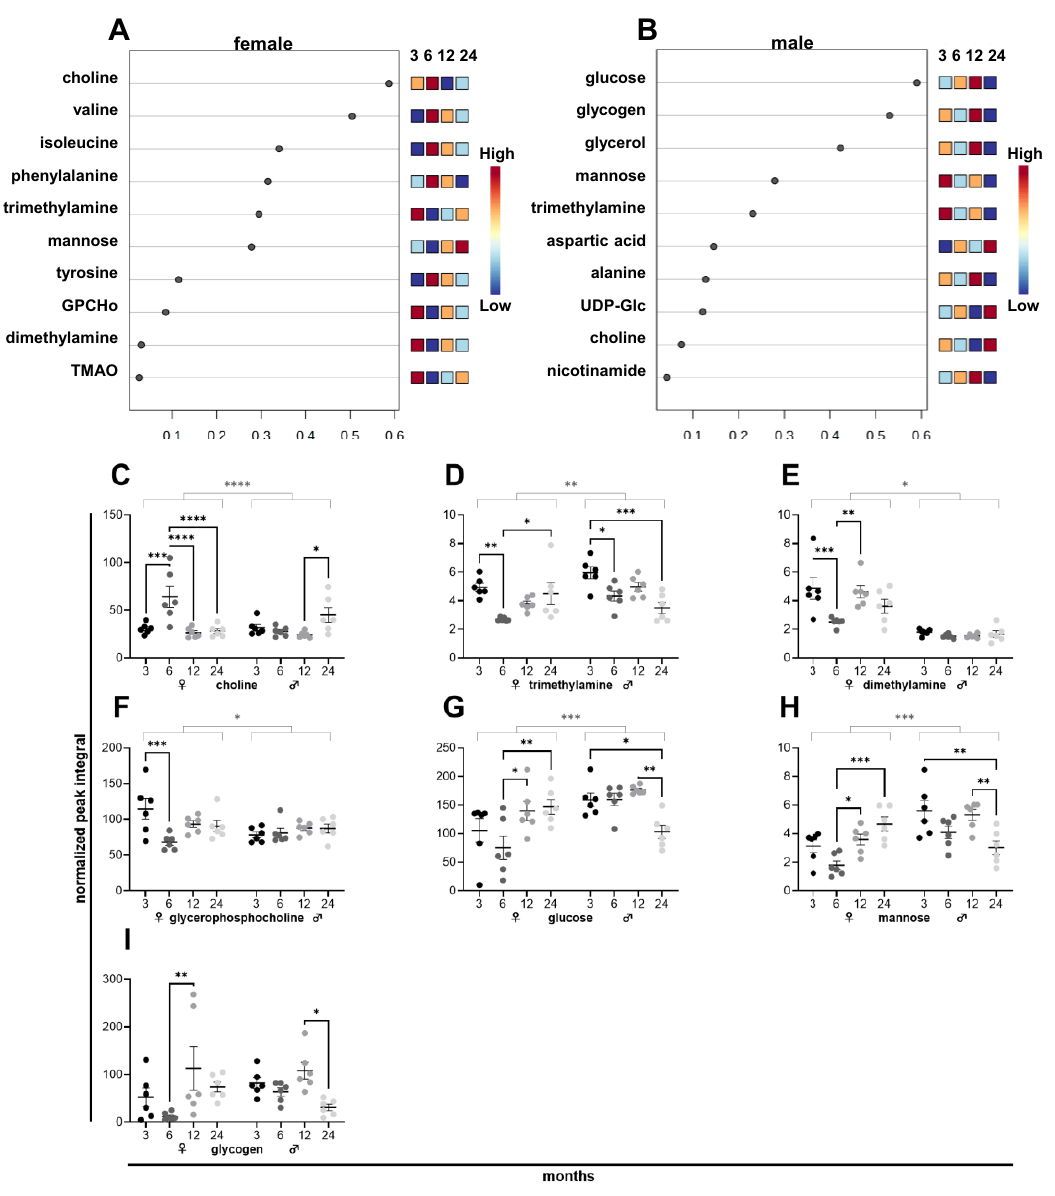
Figure 3. NMR metabolomics of female and male murine liver samples. Metabolites of six female ( A ) and six male ( B ) mice ranked based on the variable importance during projection (VIP) score as a function of age. Individual metabolite levels of female (left) and male (right) tissues at 3, 6, 12, and 24 months presented as normalized peak integral ( C – I ). GPCho Glycerophosphocholine, TMAO Trimethylamine